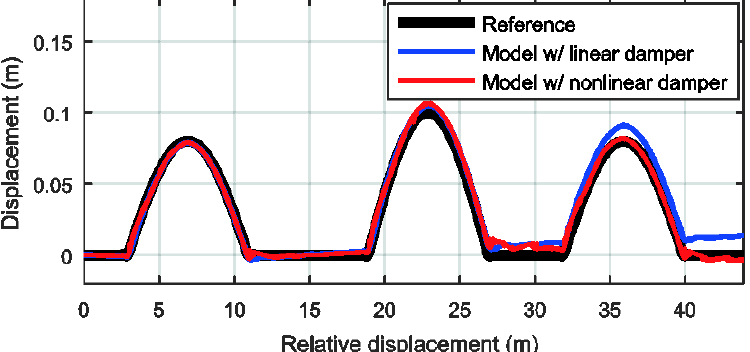
Figure 4. Simulation environment.